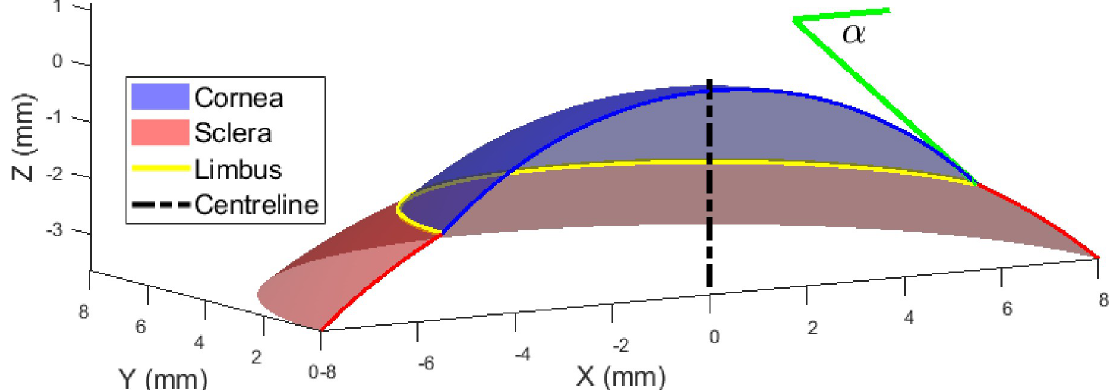
Fig 3. Graphical representation of the angle that the corneal surface makes at the point of connection to the limbus. The tangent angle at the limbus is represented by α .